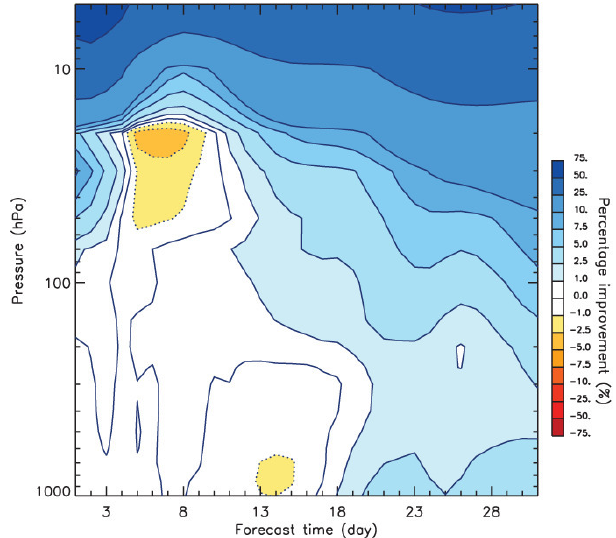
Figure 18. Average improvement in predictive skill for geopotential height anomalies in the SH poleward of 60 ◦ S in ensembles of 30d forecasts from mid-November for the years 1979–2008 when the vertical resolution in the forecast model is increased above 100hPa (Roff et al., 2011). In the troposphere, improvements of ∼ 5% are seen 3–4 weeks into the forecasts. Note the non-linear scale for the shading. Figure 2a from Roff et al. (2011). ©American Geophysical